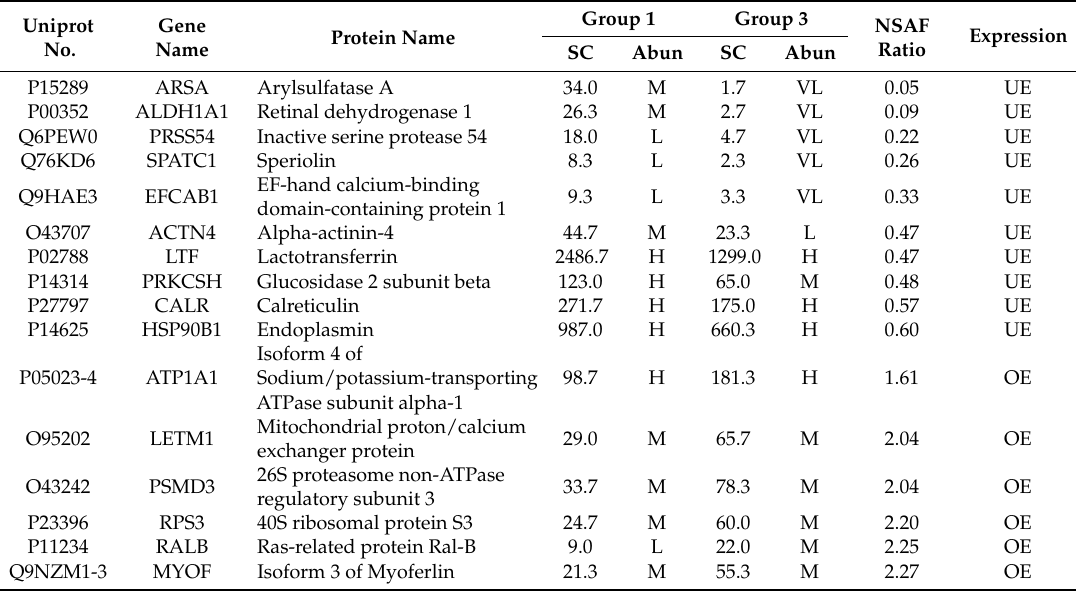
Isoform 4 of transporting ATPase subunit alpha-1